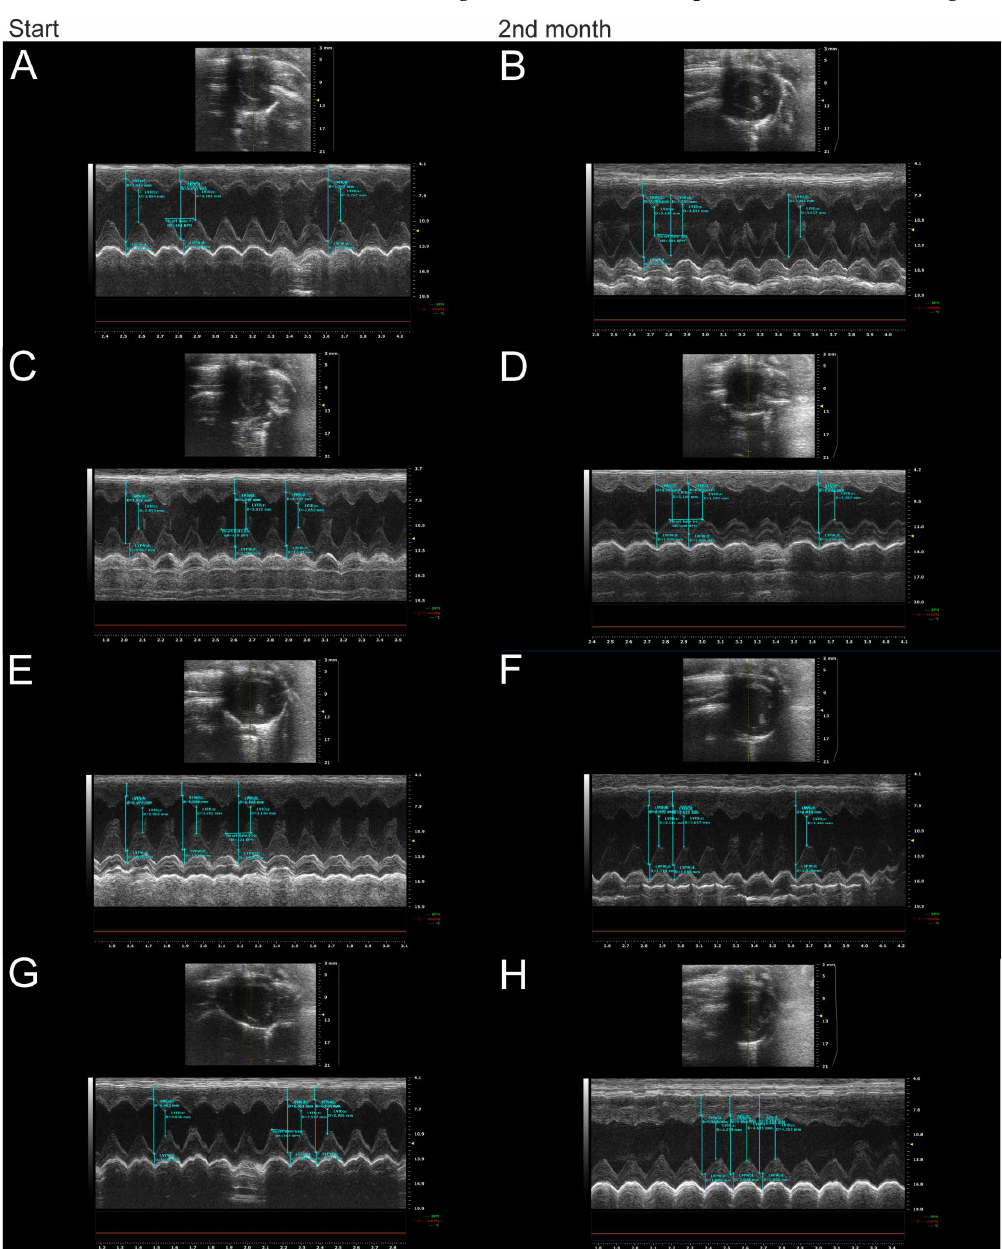
Figure 4. Representative ECHO photographs of control, DOX, NR+DOX, and NR/NR+DOX groups at the start of the experiment and two months after doxorubicin administration comple- tion. ( A , B )—control group; ( C , D )—DOX group; ( E , F )—NR+DOX group; and ( G , H )—NR/NR+DOX group. DOX represents doxorubicin group; NR+DOX represents nicotinamide riboside + doxorubicin group— combined mode ; and NR/NR+DOX represents nicotinamide riboside/nicotinamide riboside + doxorubicin group— preventive mode